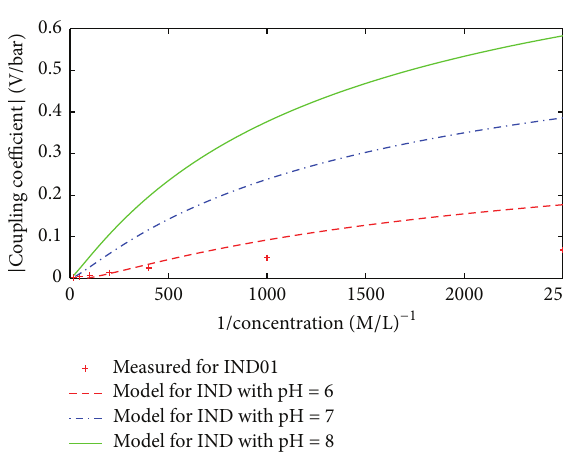
Figure 3: Measured and modeled results of the coupling coefficient for IND01. Three pH values (6, 7, and 8), the zeta potential offset ( 𝜁 𝑜 = 0.045 V), and proton surface conductance 𝑐 were used in the